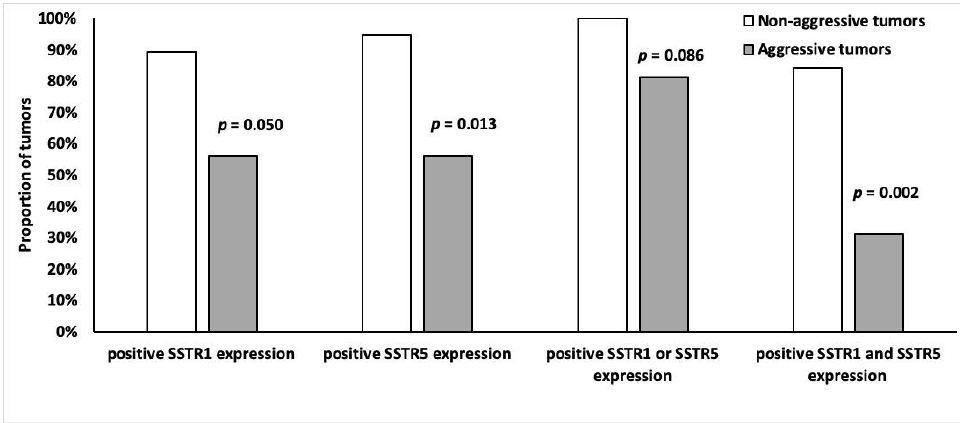
Figure 8. Frequency of SSTR1 and SSTR5 (%) positivity (overall score 2–4) among indolent ( n = 19) and malignant ( n = 16) tumors.